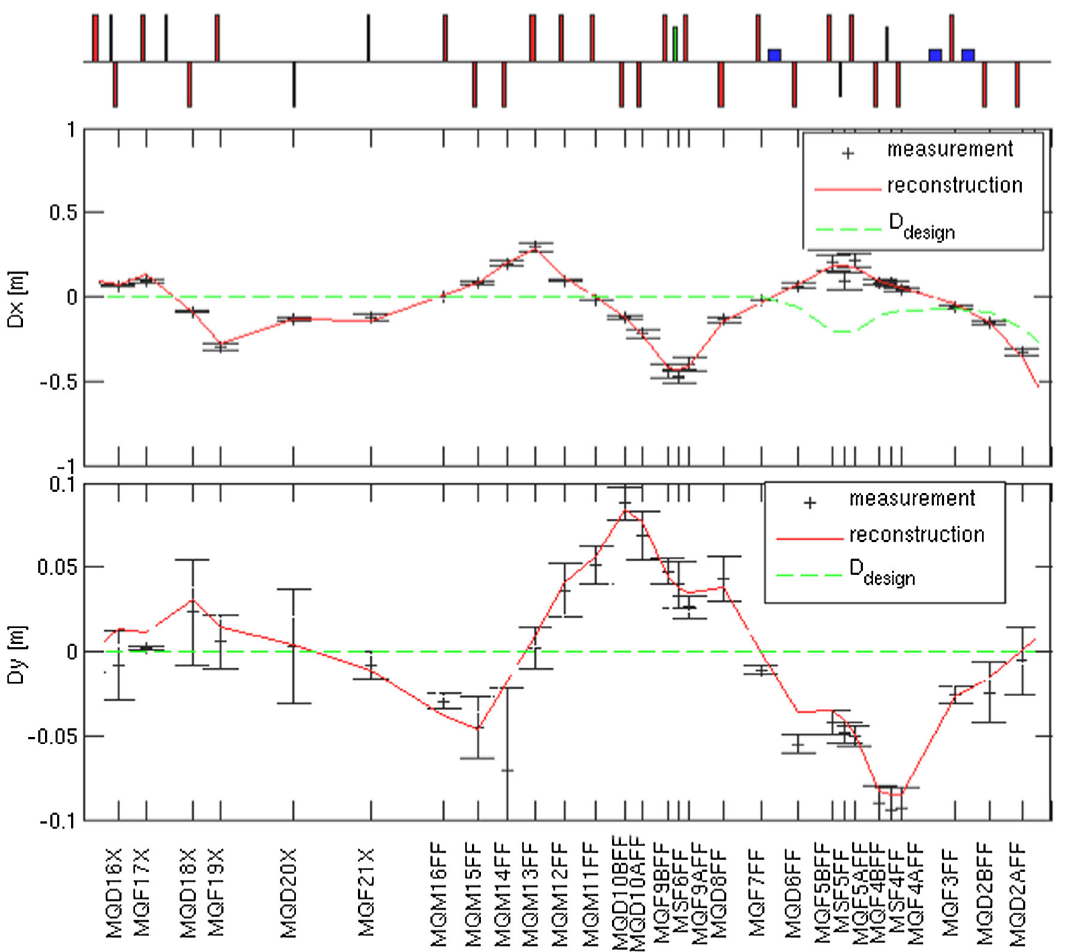
FIG. 8. Reconstructed dispersion compared to individual BPM measurements based on using beam fluctuations.